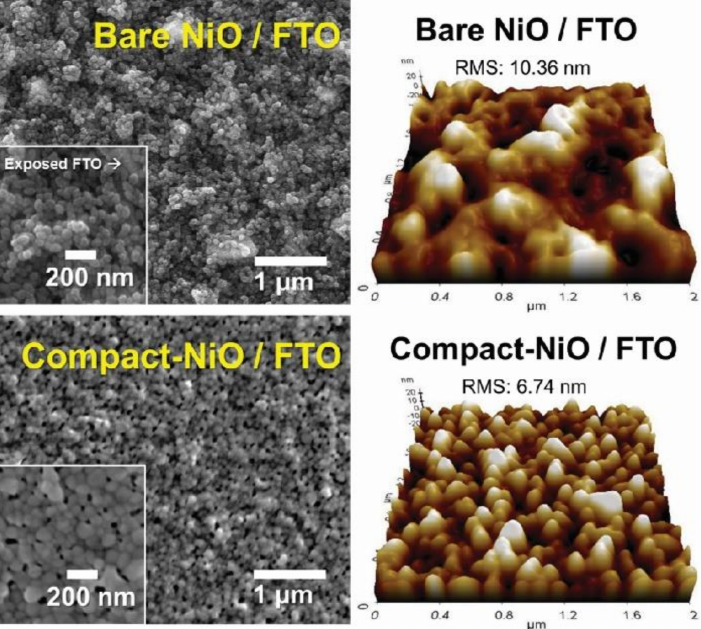
Figure 6. AFM and SEM images of bare nickel oxide on FTO (without PEG) and compact nickel oxide (c-NiO) on FTO (with PEG). Adapted with permission from